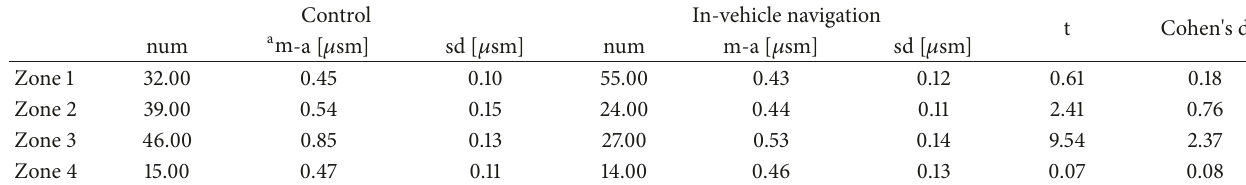
Table 5: Statistical results of SCR between the control condition and in-vehicle navigation condition.